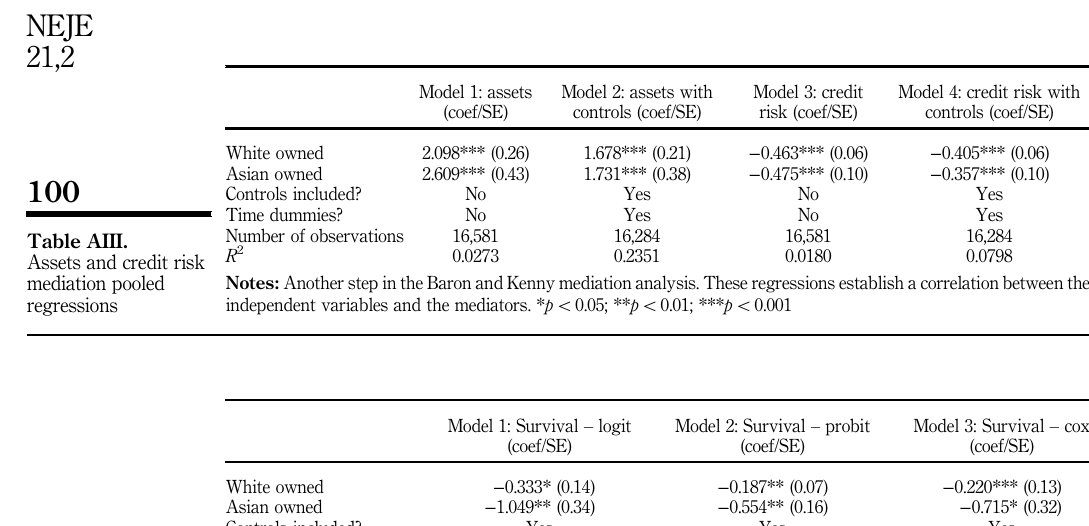
Table AIV. Alternative models for new venture